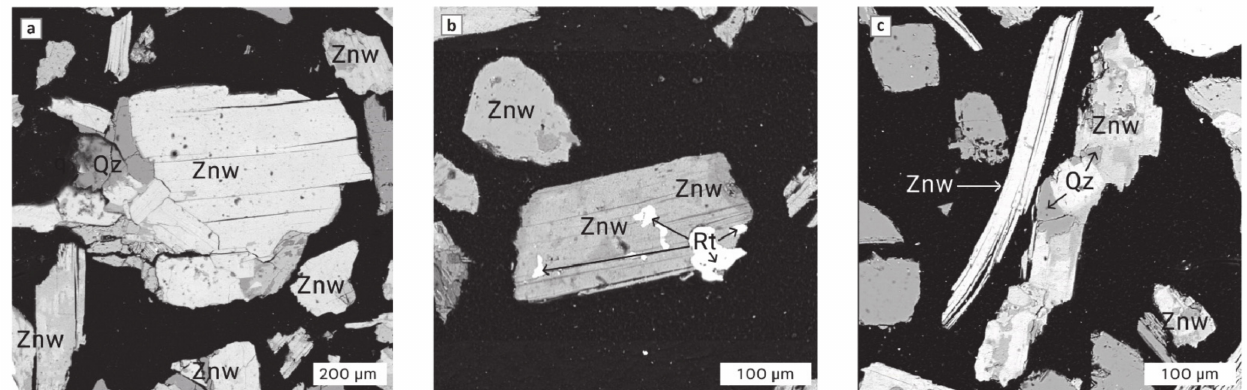
Figure 8. SEM/EDS-BSE images of Li-micas grains. Explanation: Qz = quartz, Znw = zinnwaldite, Rt = rutile. ( a ) zinnwaldite intergrown with quartz, ( b ) zinnwaldite with rutile, ( c ) zinnwaldite with quartz.